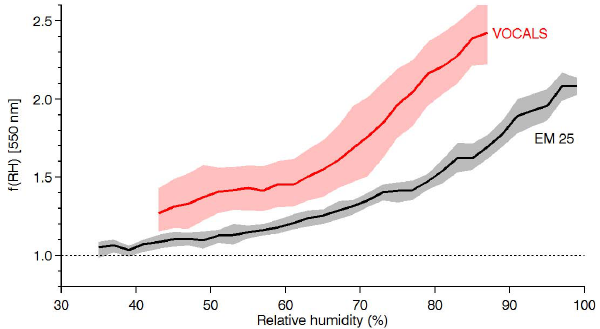
Fig. 8. Campaign-averaged ratios of humidified-to-dry corrected light scattering coefficients for 550nm as a function of relative humidity during the EM25 (London, black) and VOCALS (south- eastern Pacific, red, Allen et al., 2011) campaigns. Solid lines in- dicate the median values and the shaded region shows the inter- quartile range. Dashed line shows no change in light scattering upon humidification.